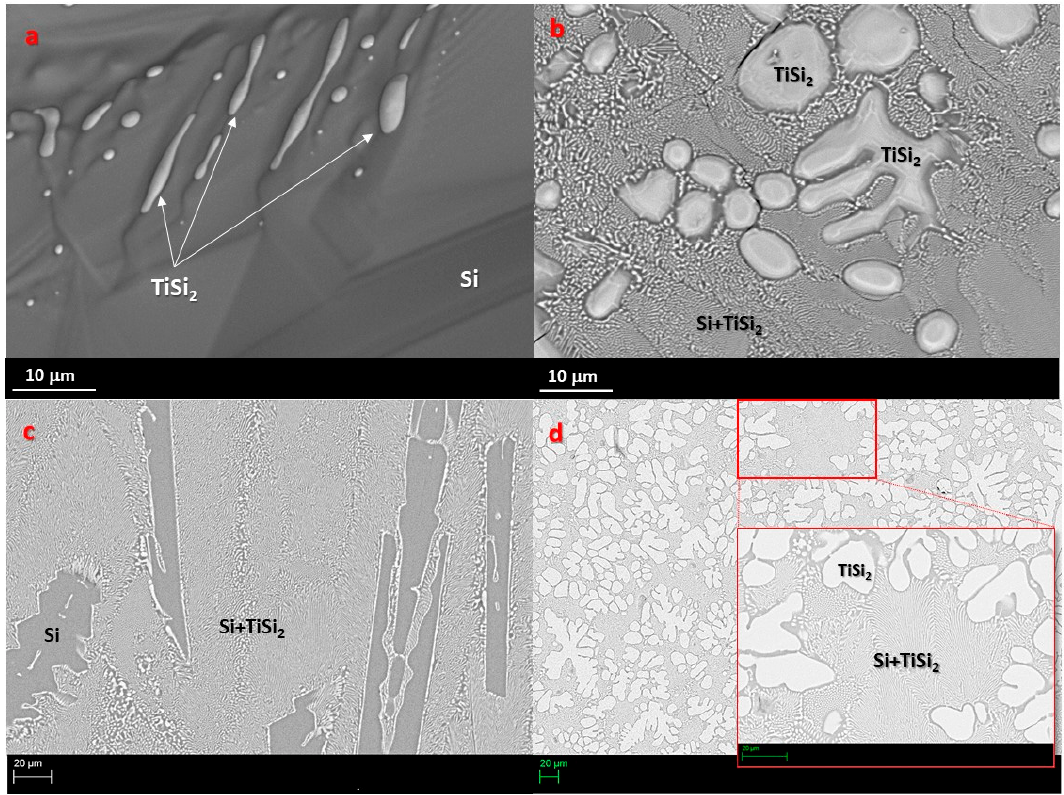
Figure 1. SEM-BSE images and phase identification by EDS analyses performed both at the ( a , b ) top of the solidified and at the ( c , d ) cross-sectioned Si-8at% Ti and Si-24at% Ti alloy samples after arc melting.